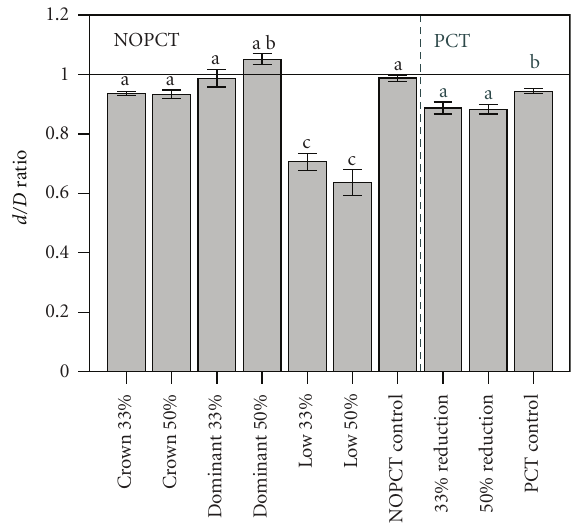
Figure 1: Mean ± one standard error pre- to postthinning average diameter ratios ( d/D ) for the commercial thinning types (crown, dominant, low) and reduction levels (33% and 50%) implemented by the Cooperative Forestry Research Unit Commercial Thinning Research Network. Statistical analysis was conducted independently for PCT (precommercial thinning history) and NOPCT (no history of precommercial thinning) groups. Letters represent significant di ff erences determined using Tukey’s test.